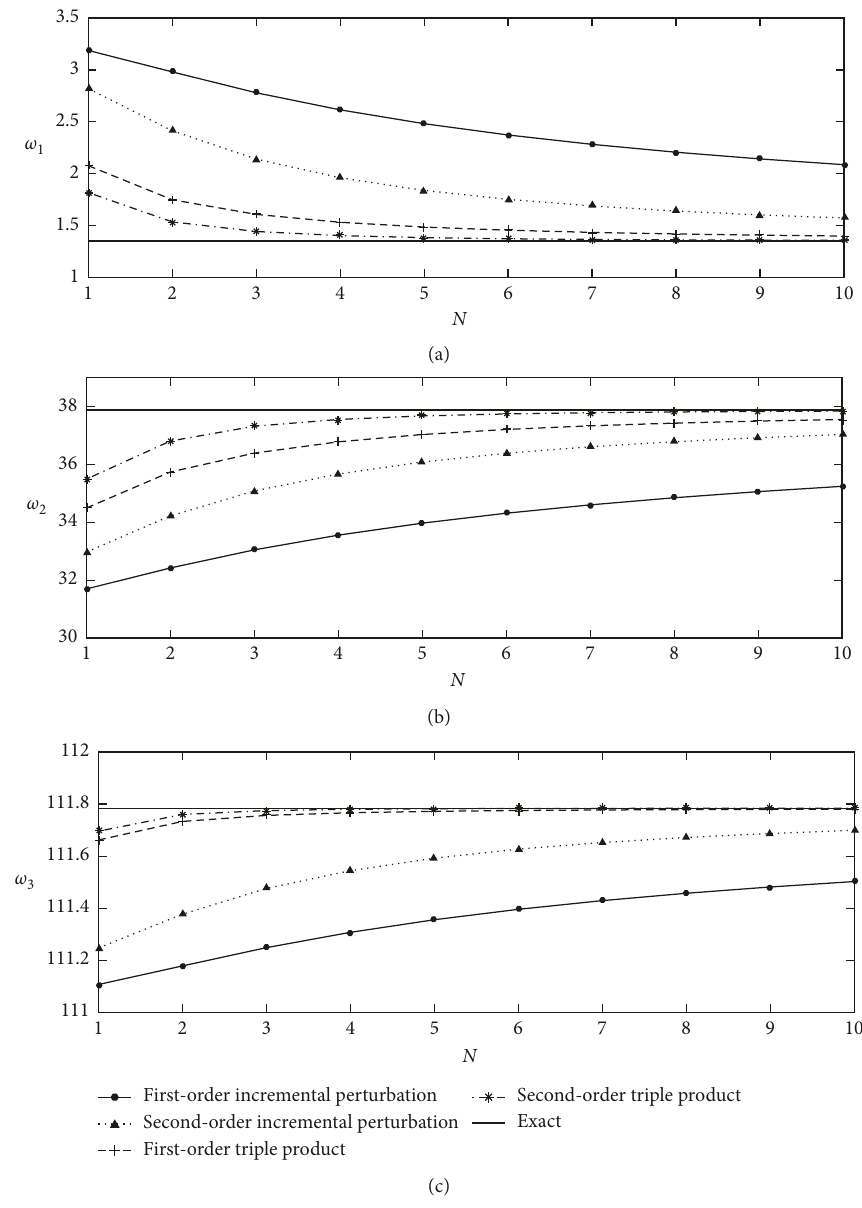
Figure 3: The approximate natural frequencies of the torque-free rigid body as a function of N for σ Table 2: The exact and approximate natural frequencies for the perturbed torque-free rigid body at N First-order incremental Exact perturbation ω